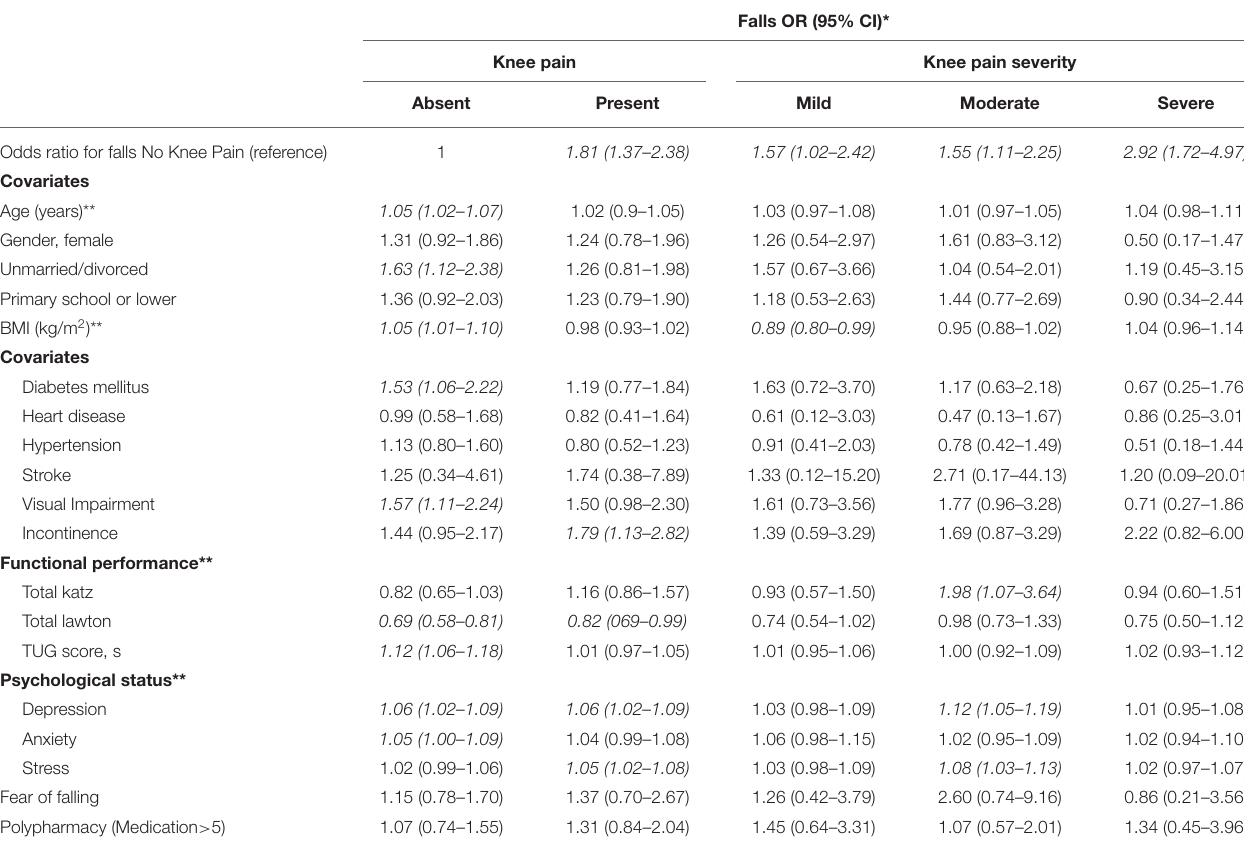
TABLE 2 | Risk of falls according to knee pain or knee osteoarthritis status.